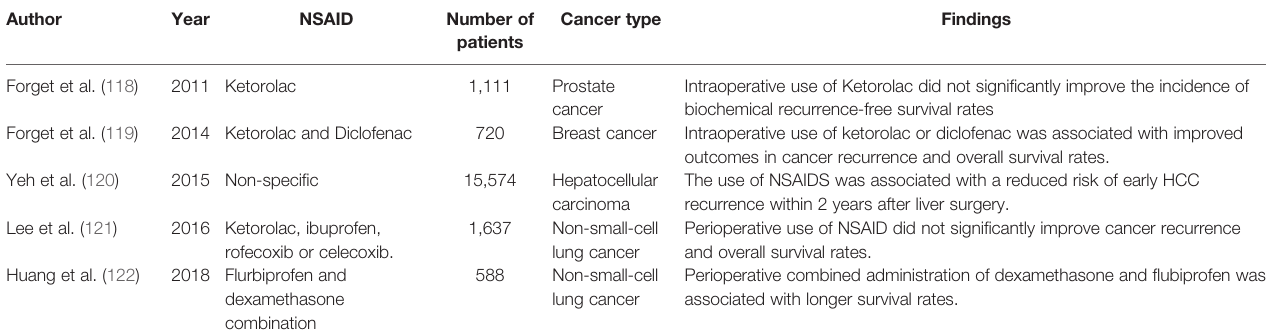
TABLE 3 | Selected retrospective studies examining the association between perioperative administration of NSAID and cancer recurrence and overall survival